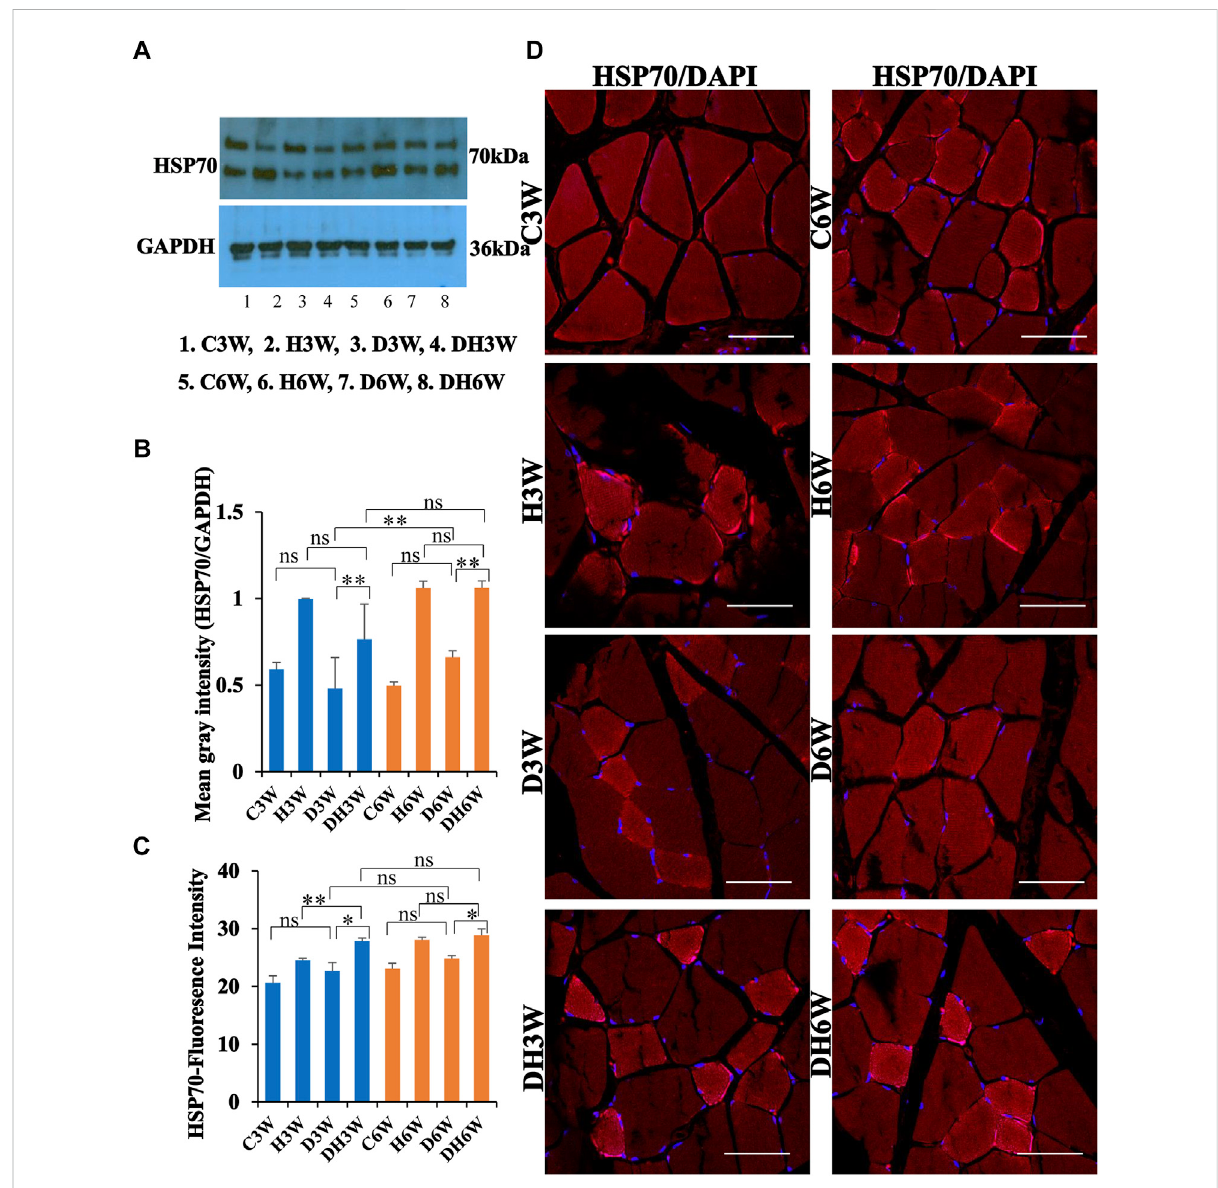
FIGURE 12 (A,B) Immunoblots probed with anti-HSP70 antibody (A) and mean gray intensity of immunoblots (B) . Note that there was no signi fi cant difference in the expression of HSP70 (mean grey intensity) in D3W and D6W compared to C3W and C6W respectively. HSP70 expression was signi fi cantly increased in DH3W and DH6W compared to D3W and D6W, respectively. There was a signi fi cant increase in HSP70 expression from short-term(D3W)tolong-term(D6W). (C,D) HSP70immuno fl uorescenceintensity (C) andrepresentativecrosssectionofmuscle fi bersstained for anti-HSP70 immuno fl uorescence in short term (left panel) and long term (right panel) experiments (D) . Western blot data of HSP70 expression is further supported by fl uorescence intensity measured on the anti-HSP70 immunostained sections of the muscle fi bers in most of the